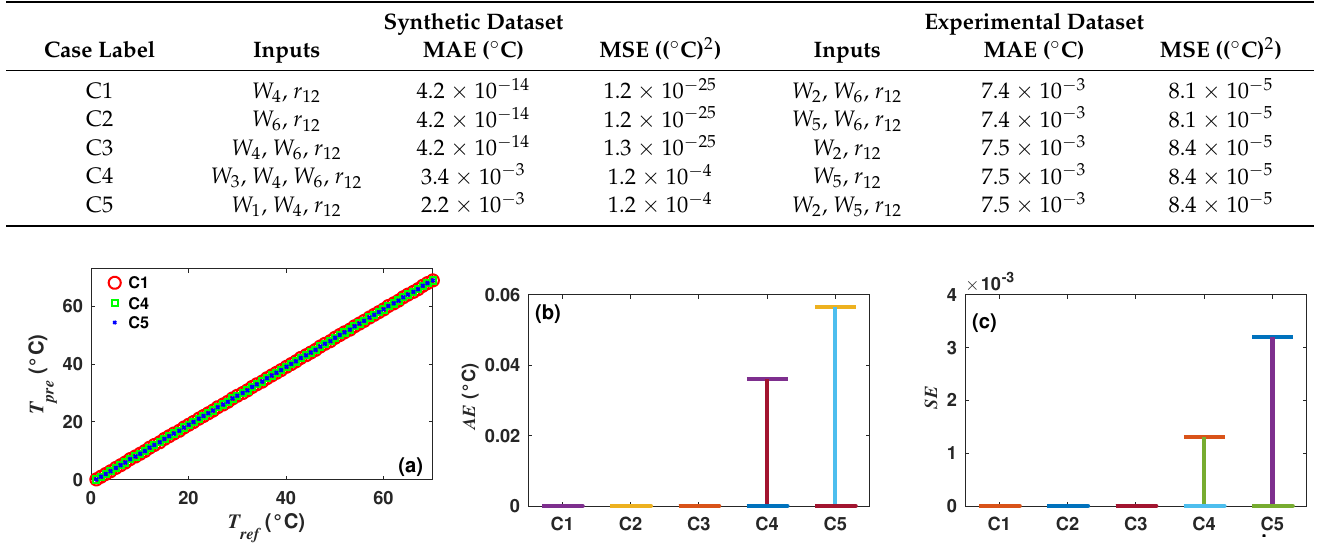
Figure 8. ( a ) Reference and estimated temperatures obtained with the methodology for the synthetic dataset of filter 1; ( b , c ) corresponding AE and SE distributions obtained with different inputs